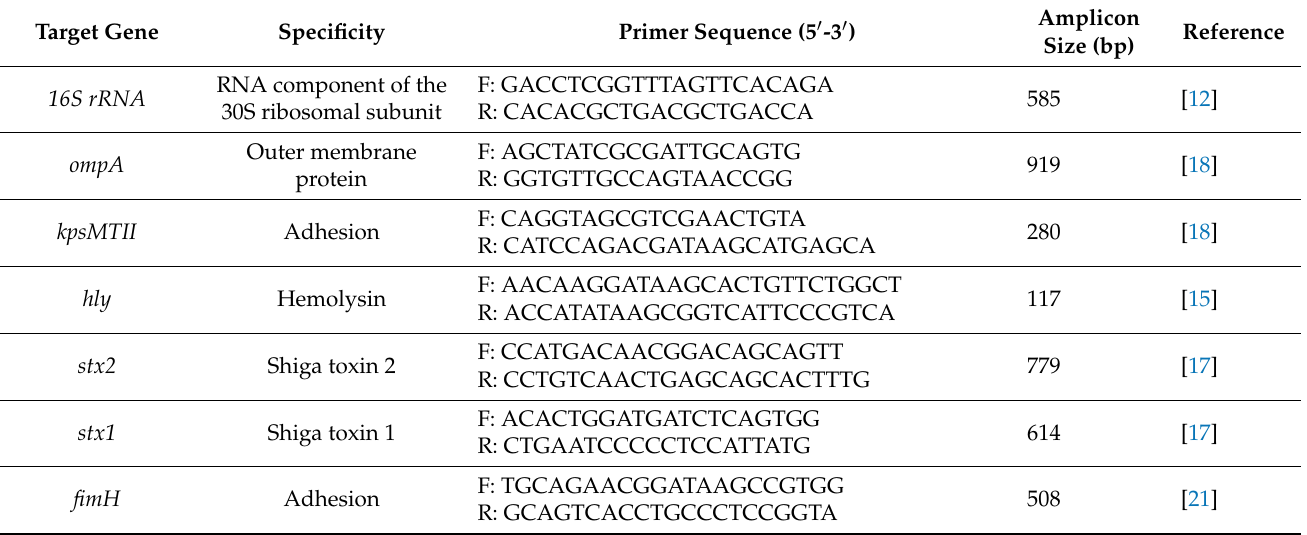
Table 1. The primer sequences and the predicted amplicon sizes of the diarrheagenic E. coli genes under